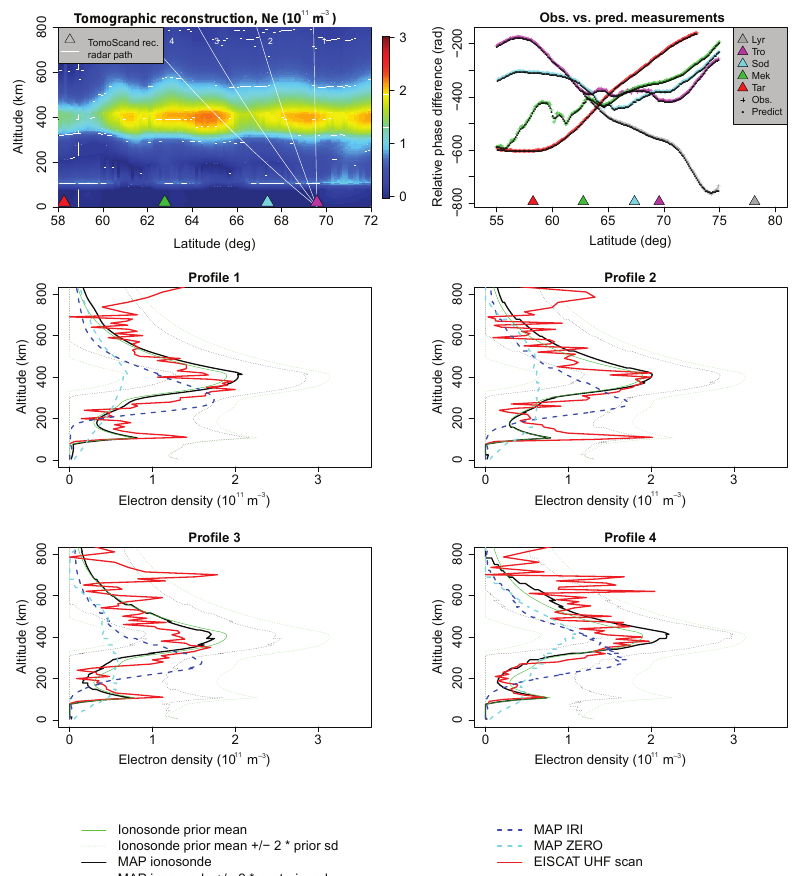
Figure 8. Reconstruction, phase curves and profile comparisons for Overflight IV starting on 20 November 2014 at 02:50UTC.